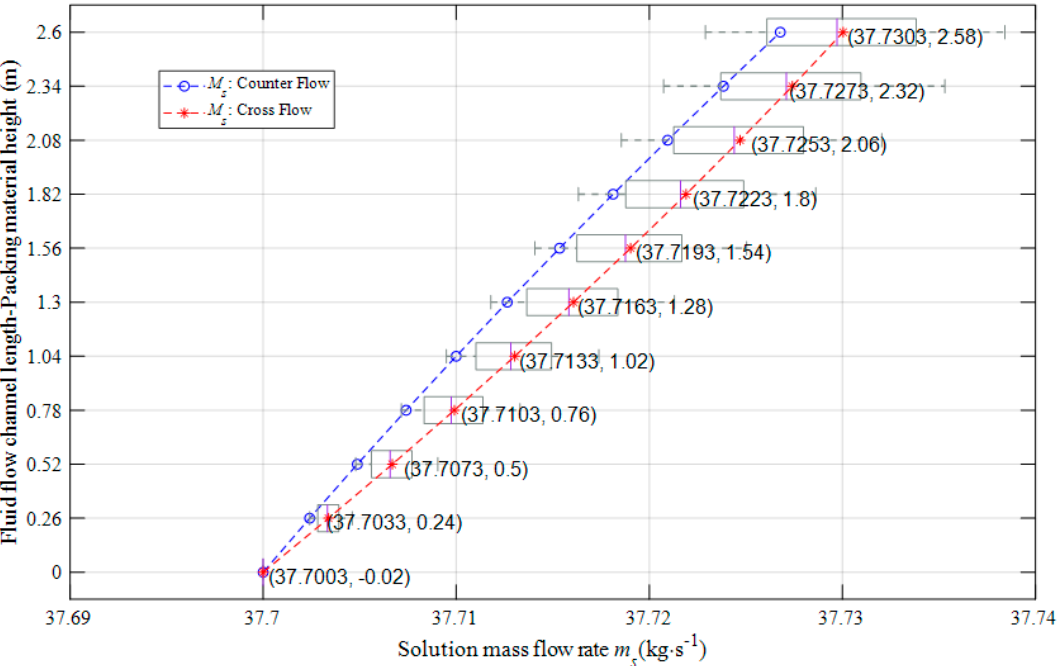
Figure 11. Profile of solution mass flow rate along the fluid flow channel length.